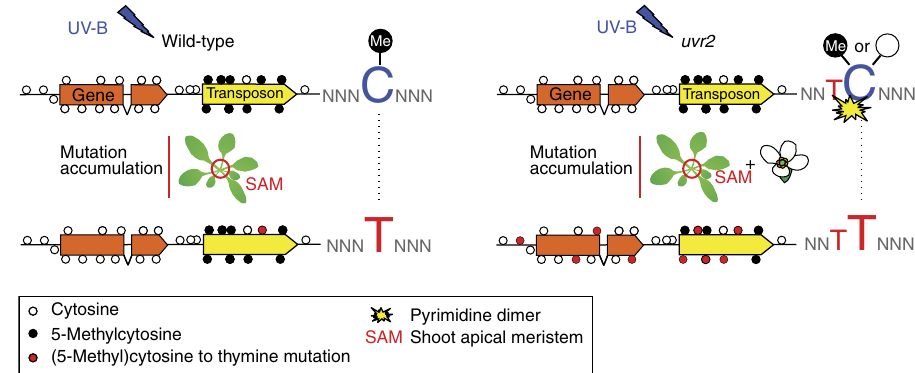
Figure 4 | Model for accumulation of UV-B-induced germline mutations in A. thaliana